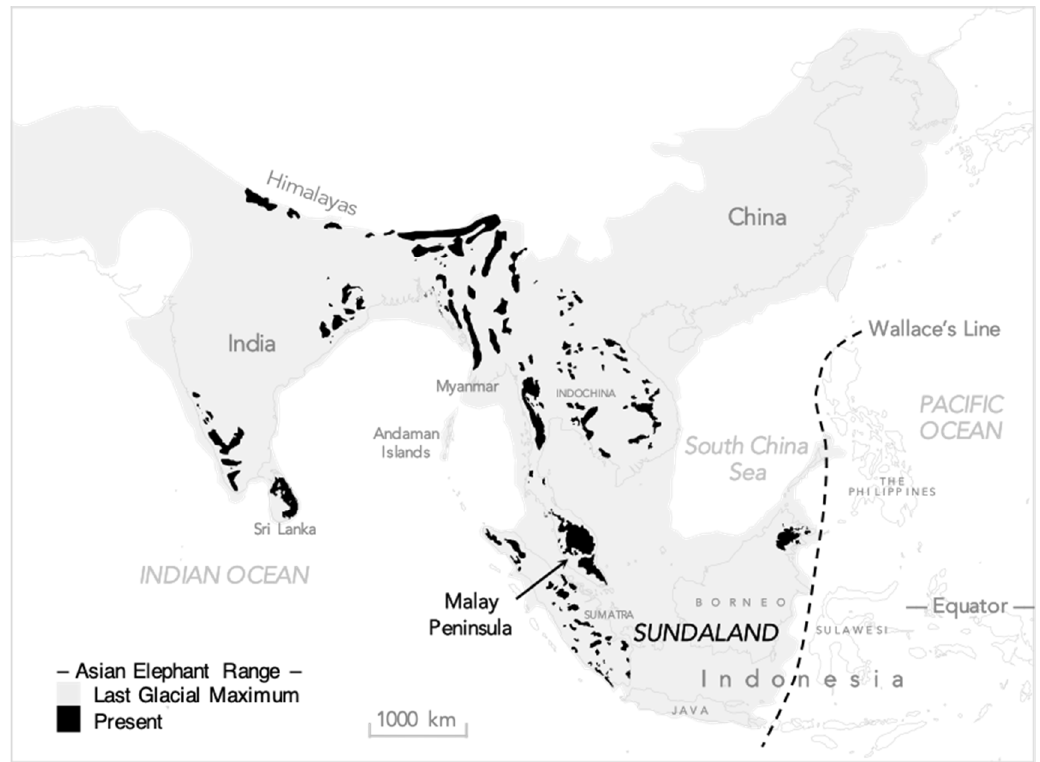
Figure 1. Approximate range of Asian elephants at the last glacial maximum (25,000–15,000 years ago), and at present. Note: The species ranged west to Turkey (not shown on this map). Reprinted from Ref: [8,22]. Made with Natural Earth.